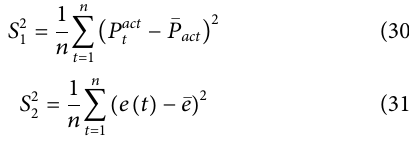
Frontiers in Energy Research |